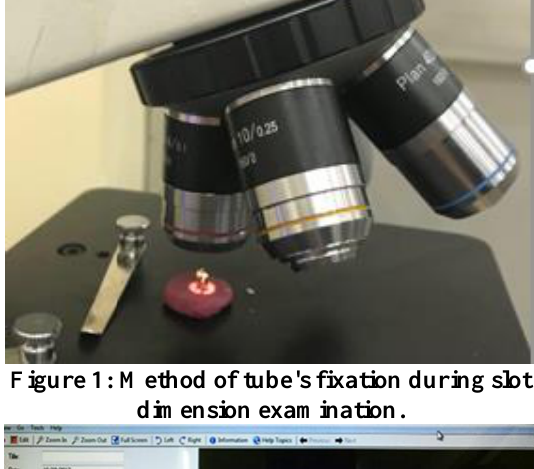
Figure 1: Method of tube's fixation during slot dimension examination.